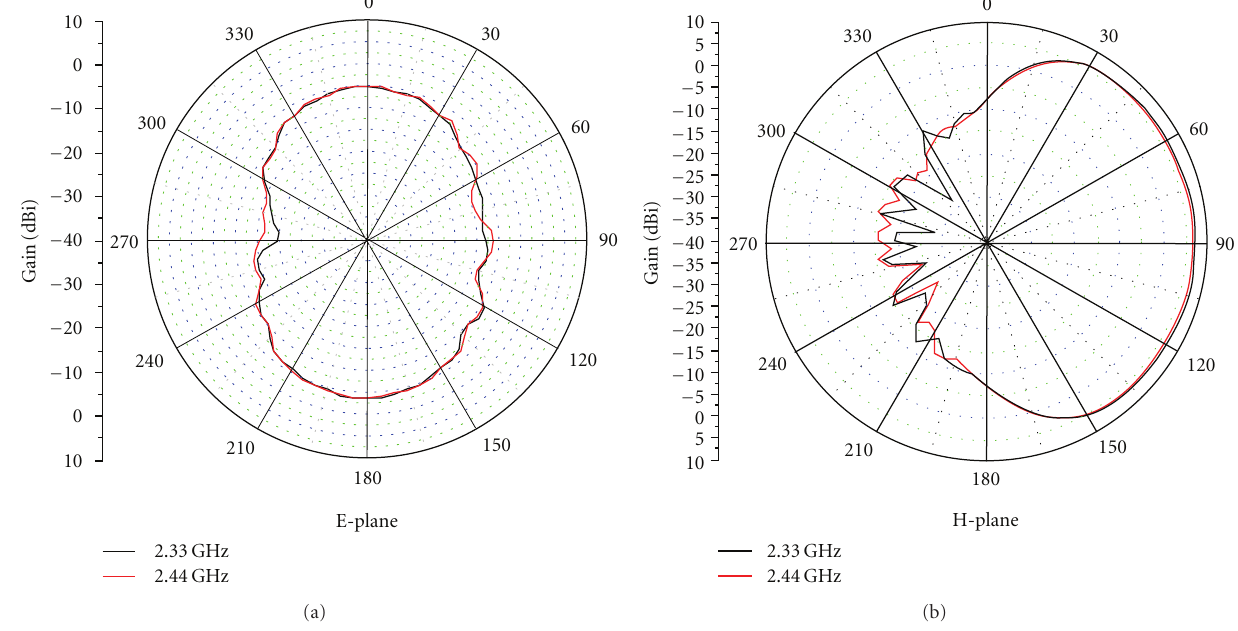
Figure 14: Experimental radiation diagrams of dipole on reflector plate at 2.44 GHz and 2.33GHz.